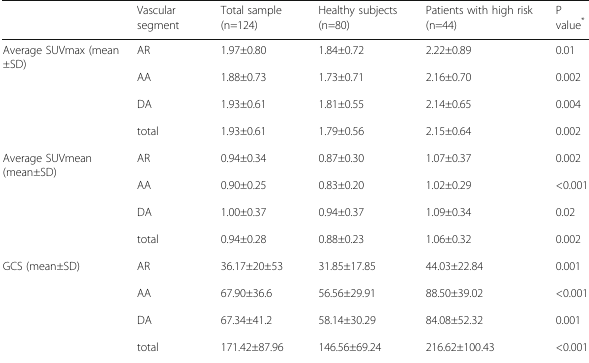
Table 2 (abstract A30). Correlations between measures of NaF uptake (Average SUVmean, Average SUVmax and GCS) in the three